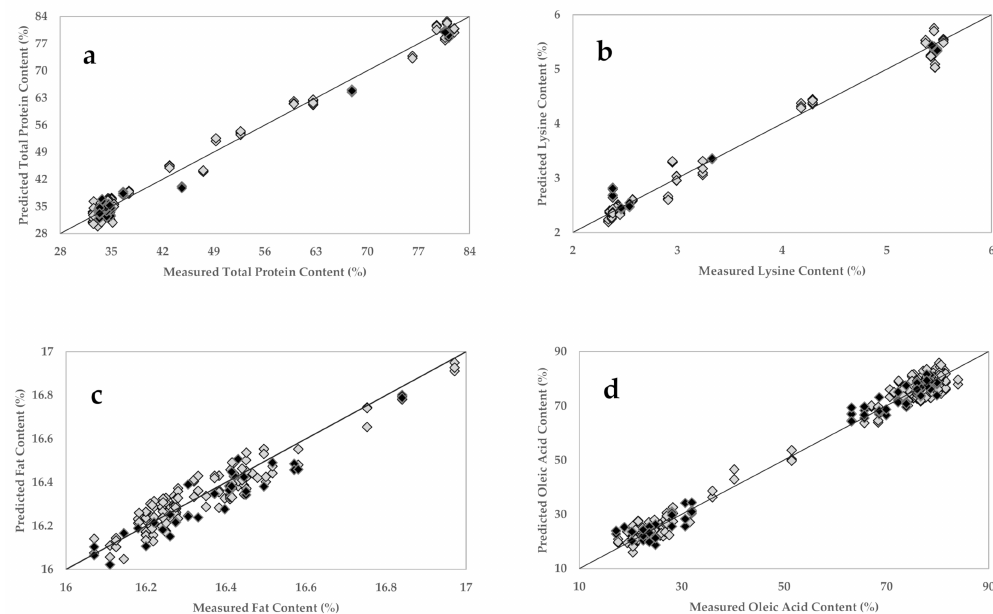
Figure 4. Partial least squares regression (PLSR) calibration and external validation plots for total protein ( a ), lysine ( b ), fat ( c ), and oleic acid ( d ) contents in soybean samples using the handheld NIR sensor. Grey diamonds represent samples in the calibration set; black diamonds represent samples in external validation